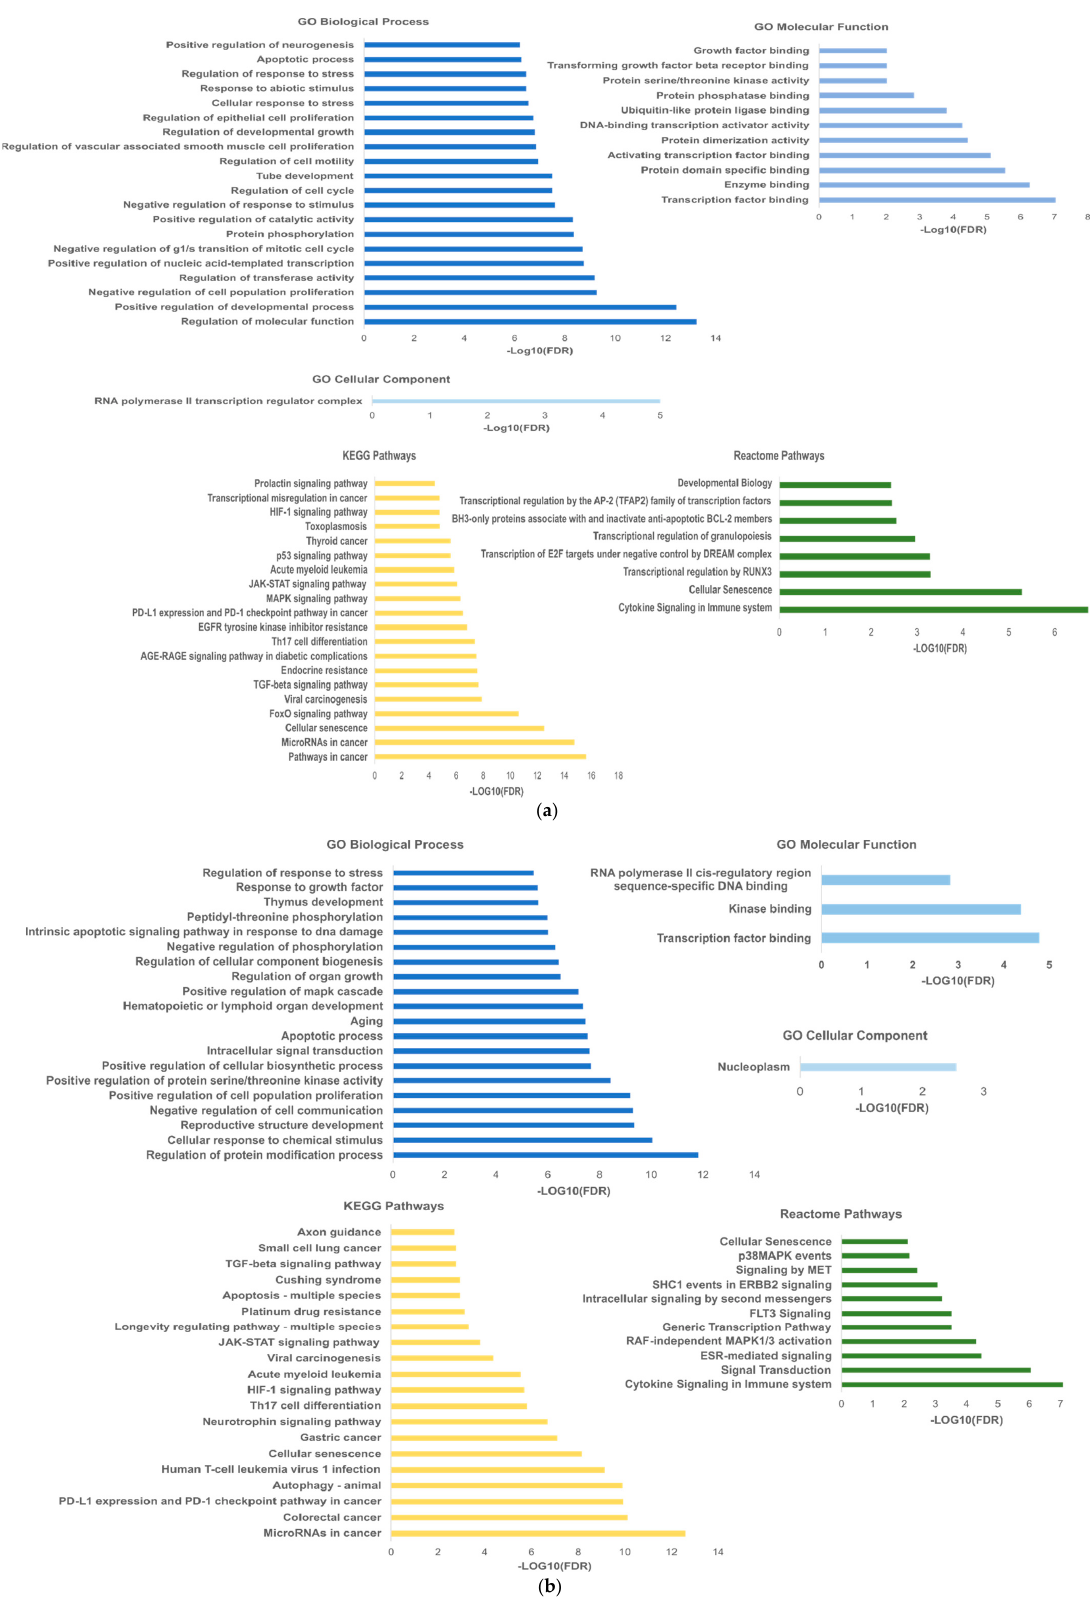
Figure 3. Data integration of the lncRNA–miRNA–mRNA networks related to hsa-miR-20a-5p and hsa-miR-181a-5p.